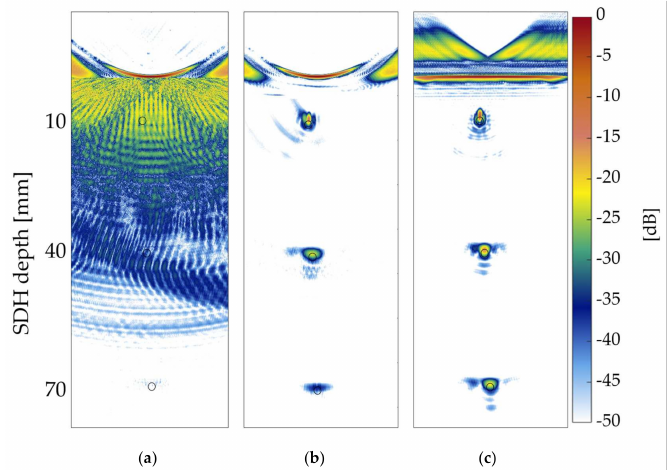
Figure 10. TFM image of the three side drilled holes and the specimens’ surfaces: ( a ) Concave specimen Cc15 at the probe standoff h = 40 mm; ( b ) Concave specimen Cc15 with the PSOM applied to each flaw; ( c ) Benchmark flat specimen F0 at the probe standoff h = 40